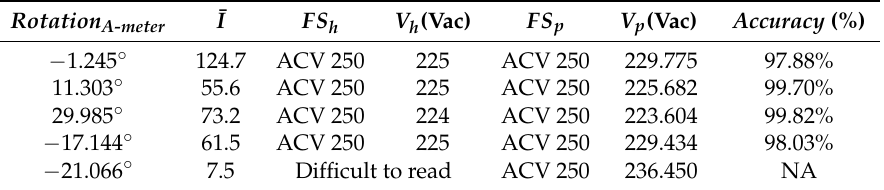
Table 6. Results of using A-meter YF-370A with function select “ACV 250” to measure the 220 Vac line power. The mean accuracy was 98.86%, where the accuracy of the fifth data point is not available since it was difficult to read with the human eye under very low illumination (¯ I = 7.5). Rotation